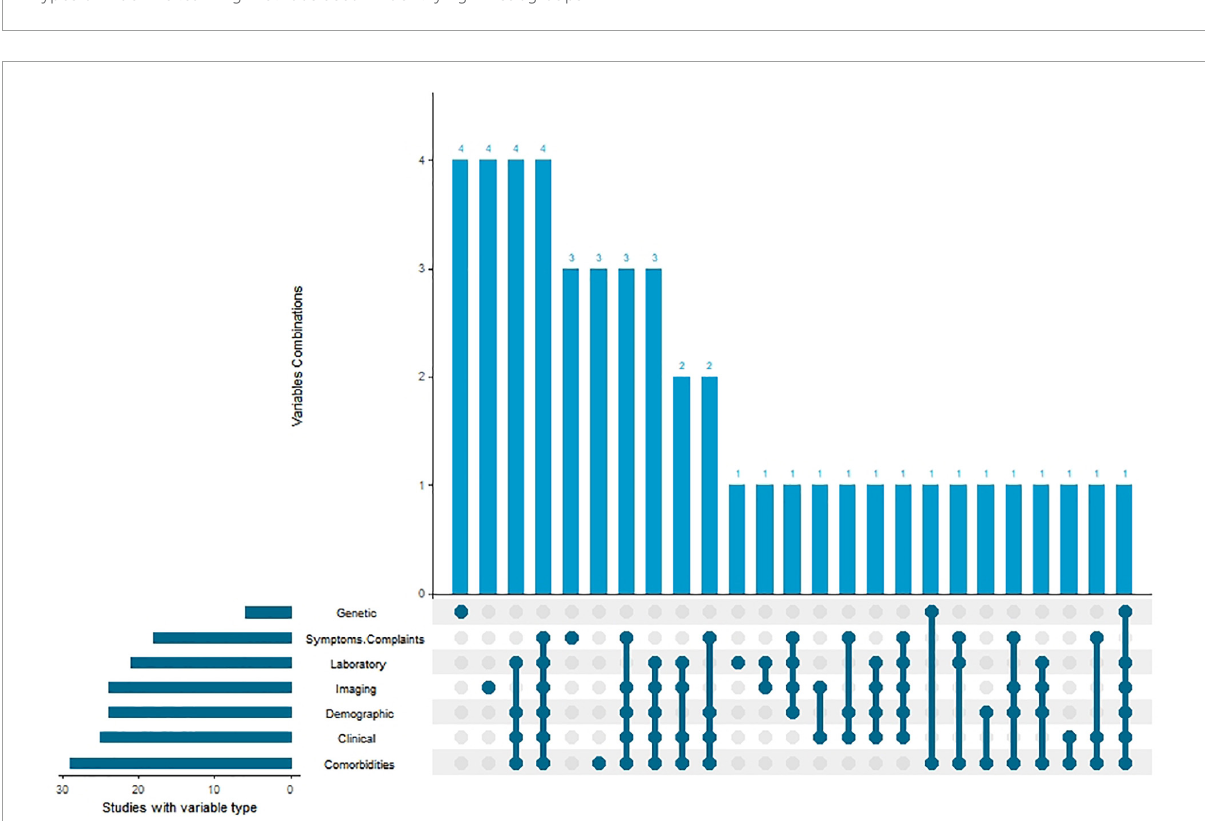
FIGURE5 Types of clustering variables used in identifying HF subgroups.